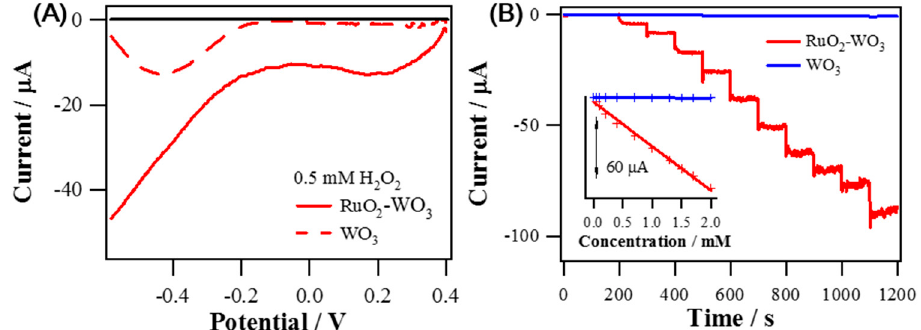
Figure 7. ( A ) Background-corrected LSVs of RuO 2 NRs-WO 3 NFs and WO 3 NFs obtained in 0.1 M PBS (pH 7.4) containing 0.5 mM H 2 O 2 with a scan rate of 5 mV s -1 , at an electrode rotating speed of 1600 rpm. ( B ) Amperometric current responses of RuO 2 NRs-WO 3 NFs and WO 3 NFs to successive H 2 O 2 injections from 0.005 mM to 2 mM in 0.1 M PBS (pH 7.4) at –0.2 V (vs. S.C.E.); the inset: corresponding calibration curves. Table 2. Summary of the analytical performances of reported Ru-based H 2 O 2 sensors. Electrodes